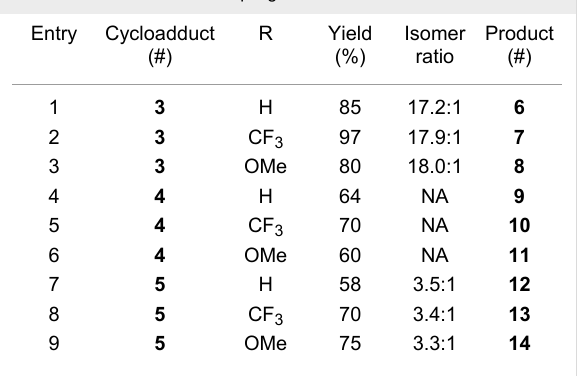
Table 2: Results of cross coupling